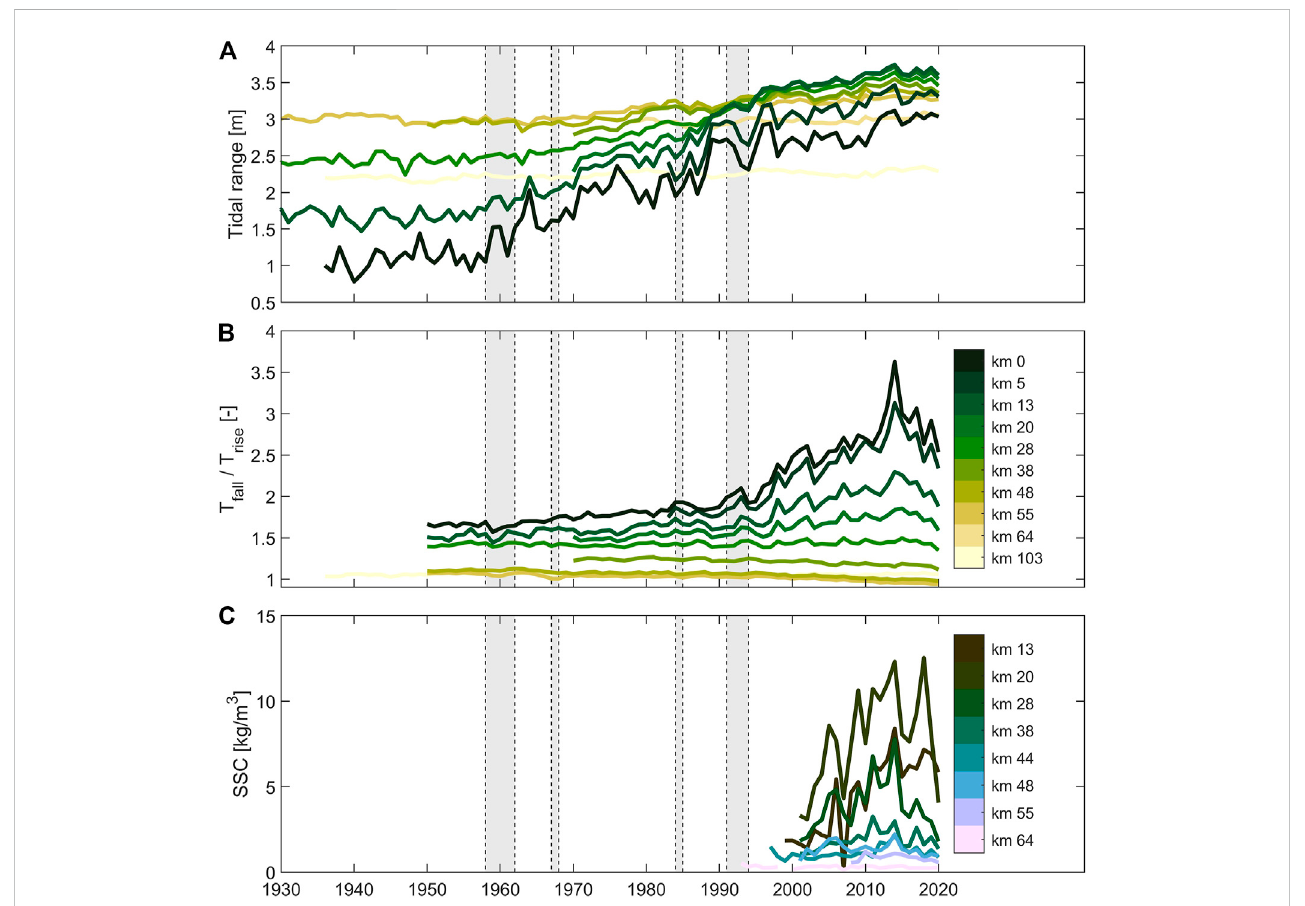
FIGURE 4 Annualtidalrange (A) ,ratioofthedurationfallingtidetorisingtide (B) andannuallyaveragedSSC (C) measuredatgaugingstationsintheEmsEstuaryand lowerEmsRiver.Thegreyshadesindicatephasedofdeepening.Between1958and1962 theapproachchanneltoEmdenwasdeepenedandthetraining wall separating it from the Dollard upgraded; the channel between Leerort and Papenburg was deepened to 5 m (below MHW) and the section between Papenburg and Herbrum narrowed. In 1967 the channel up to Leerort was deepened up to 5.5. The entire channel (Emden – Papenburg) was gradually deepened to 5.7 m (1984), 6.3 m (1991) and 7.3 m (1994). The station names are expressed as their distance from the tidal limit (the weir at Herbrum) and correspond to the following gauging station names: Herbrum (0 km), Rhede (5 km), Papenburg (13 km), Weener (20 km), Leerort (28 km), Terborg (38 km), Gandersum(44 km),Pogum(48 km),Emden(55 km),Knock(64 km)andBorkum(103 km;theestuarymouth).SSCandwaterlevellocationssometimesdiffer andarethereforeplottedindifferentcolors,butfor boththelighttonesare seawardstationsanddark